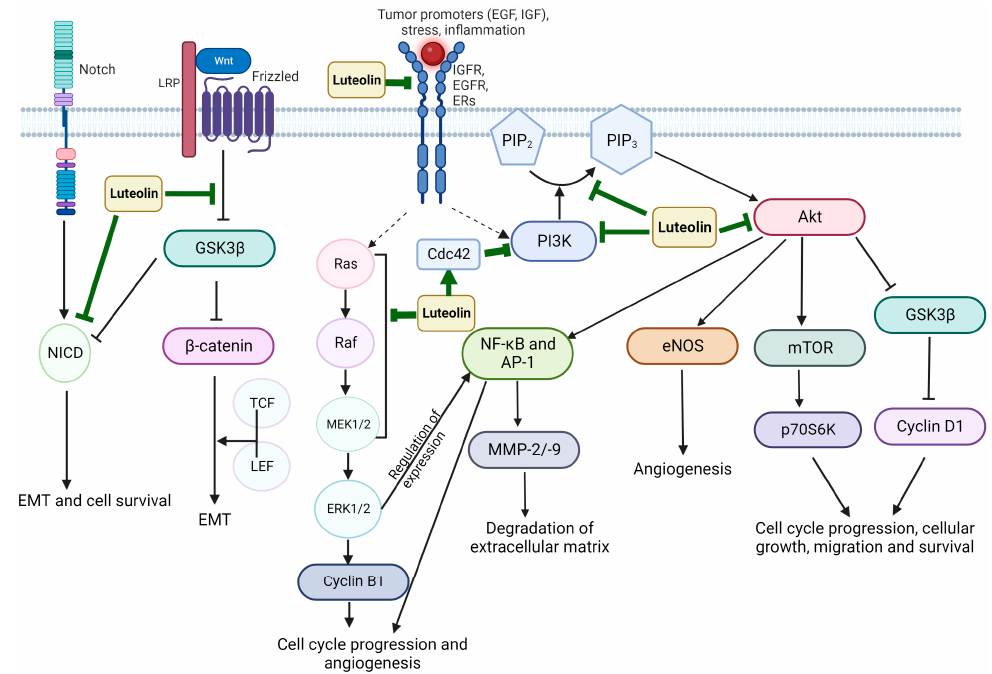
Figure 4. Summary of Luteolin’s regulation of several cancer signaling pathways in different cancer types. Luteolin can block the Notch intracellular domain (NICD) that is created by the activation of the Notch, resulting in the removal of the intracellular domain of the membrane-bound Notch via an unknown mechanism. Wnt/ β -catenin can result in inhibition of the GSK3 β activity after activation, and Luteolin can inhibit the phosphorylation of the GSK3 β induced by Wnt, resulting in the prevention of GSK3 β inhibition. Additionally, Luteolin can inhibit the activities of some receptor tyrosine kinases (RTKs) such as IGFR, EGFR, and ERs and their downstream effector molecules that result in the inhibition of several cellular processes contributing to cancer cell progression and development. Arrows designate activation ( ↑ ) and inhibition ( ⊥ ) of the molecules, and green arrows represent activation ( ) and inhibition ( ) of the molecules by Luteolin.